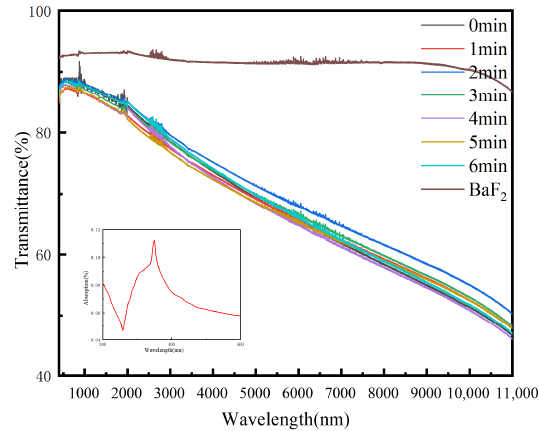
Figure 2. Transmittance of AgNWs with different UV irradiation times (400–11,000 nm). Insert of the figure shows the absorption of AgNWs at 300–500 nm.